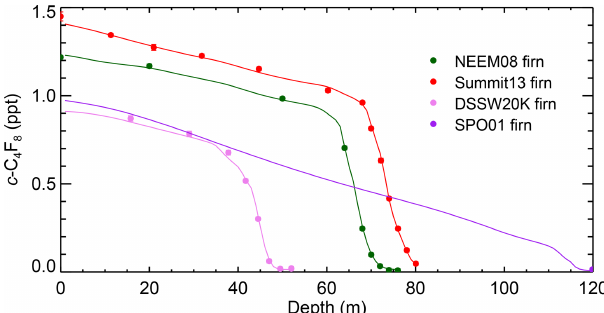
Figure 2. Depth profile of c -C 4 F 8 measured dry-air molar mole fractions (parts per trillion, ppt) in air extracted from polar firn at NEEM08 (northern Greenland, dark green) and Summit13 (Green- land, red) in the NH and DSSW20K (eastern Antarctica, pink) and SPO01 (South Pole, purple) in the SH, together with the simulated depth profiles for each site (dark green, red, pink, and purple lines) that correspond to the emissions inferred by the CSIRO inversion. The modeled depth profiles for each site (solid lines) are based on the inversion of measurements from all firn sites, archive, and in situ data. Measurement precisions (1 σ ) are shown as error bars and are generally smaller than the plotting